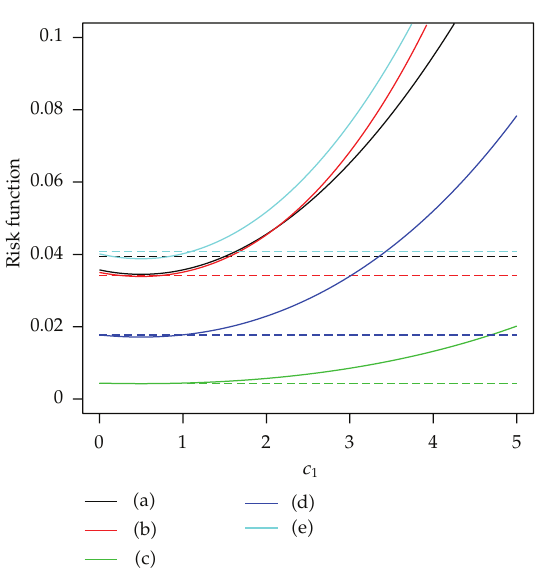
Figure 2: Risk function of estimators under the extended Je ff reys’ prior for di ff erent values of c 1 with n (cid:5) 30.